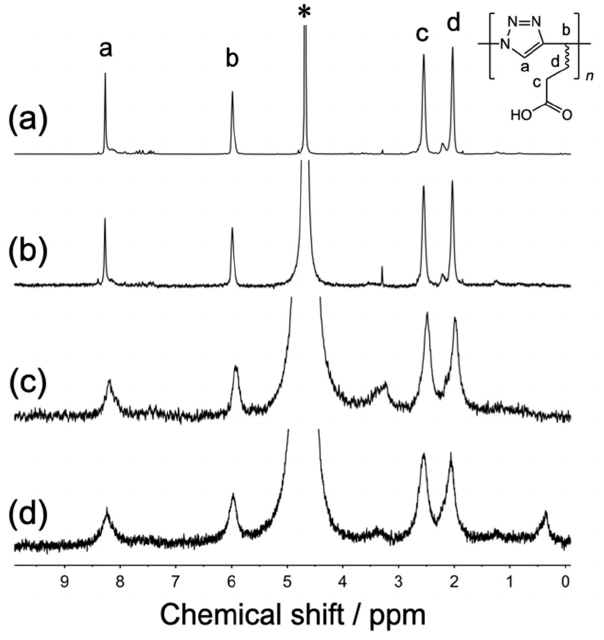
Figure 6. 1 H NMR spectrum for poly(AH)Na in the absence ( a ) and presence of 0.1 ( b ), 3.1 ( c ), and 9.1 mM of Fe(NO 3 ) 3 (D 2 O) ( d ). Assignments are indicated as a, b, c, and d. Asterisks denote the signals due to the residual protons in solvents.